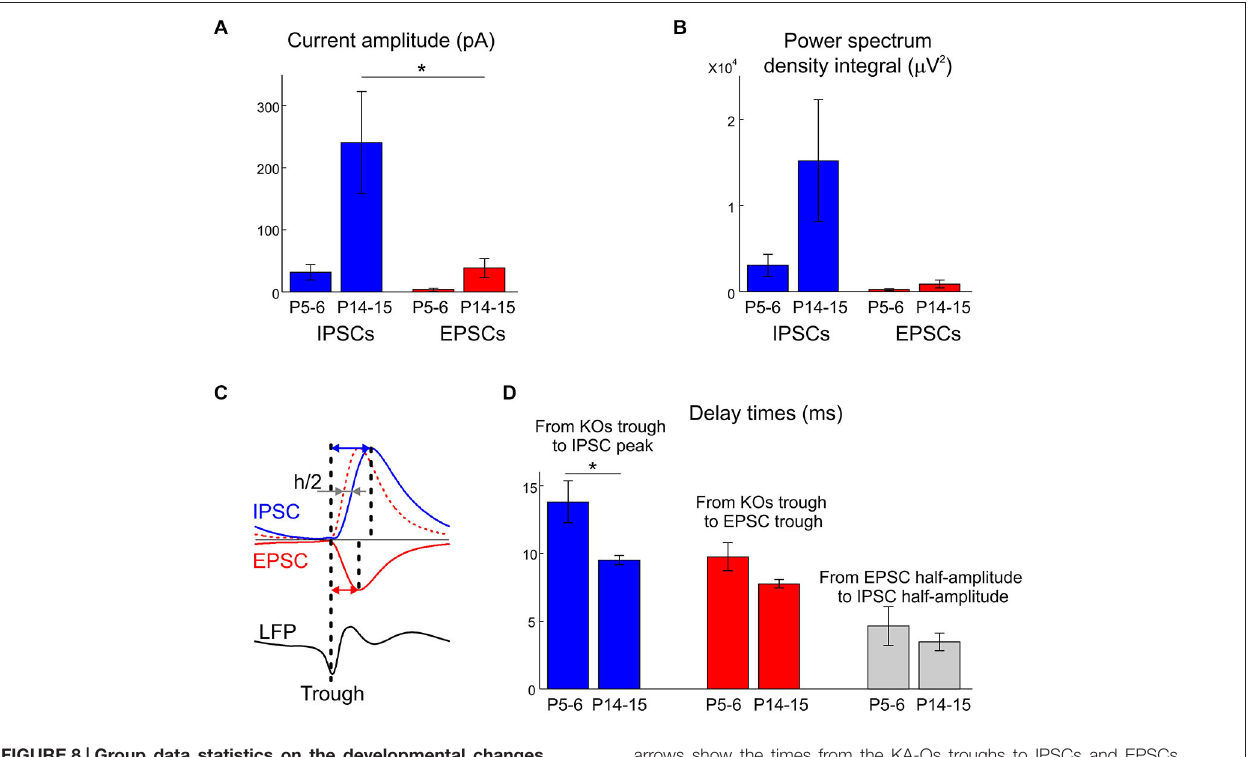
FIGURE 8 | Group data statistics on the developmental changes in synaptic contributions to KA-Os. (A) Amplitudes of IPSCs and EPSCs averaged by KA-Os’ troughs in P5–6 and P14–15 age groups. (B) PSD integrals of IPSCs and EPSCs within the KA-Os frequency band in the two age groups. (C) Calculation of delays. Blue and red